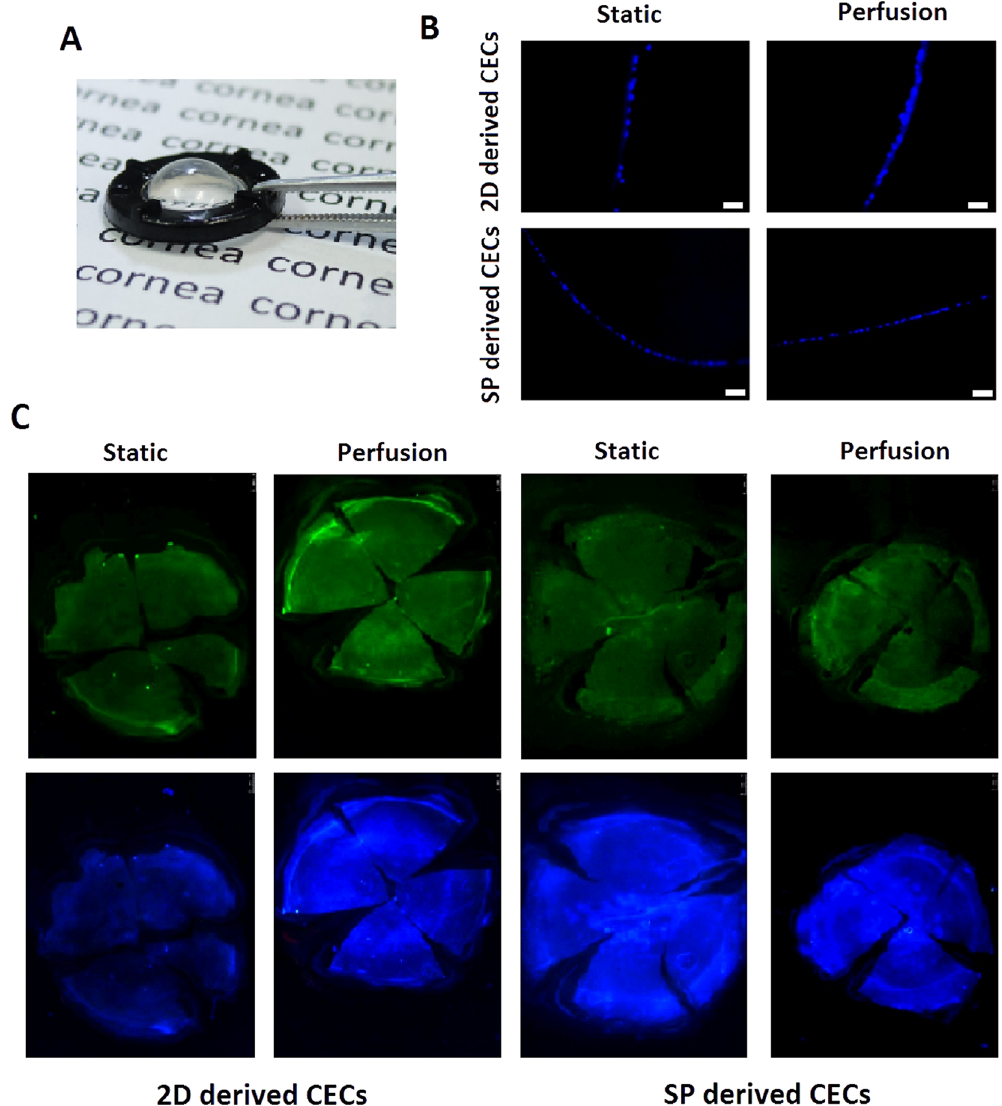
Figure 8. Tissue-engineered CECs on curved collagen sheets in the perfusion system under controlled pressure. ( A ) Photograph of a curved collagen sheet. ( B ) Immunohistochemical analysis of cryosectioned spherically curved collagen sheet by DAPI. Scale bar: 50 µ m. ( C ) Representative fluorescence microscopy images of CEC monolayers stained for F-actin and with DAPI on spherically curved collagen sheets in the static and perfusion